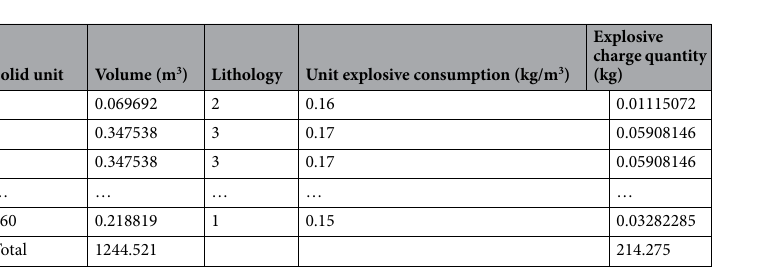
Table 5. Calculation charge quantity of blast hole